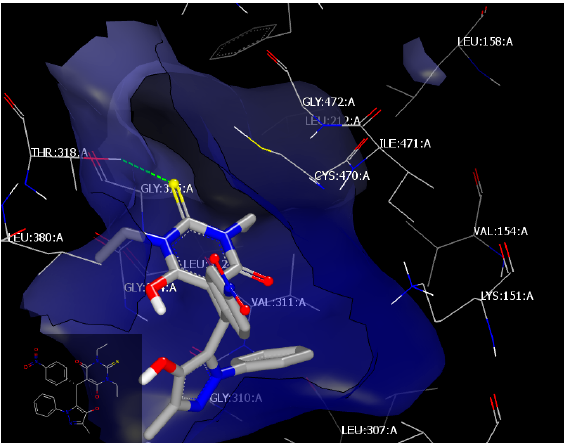
Figure 3. Visual representation of 4h docked with 4WMZ, showing hydrogen bonding interactions with THR 318:A, as shown by Vida.